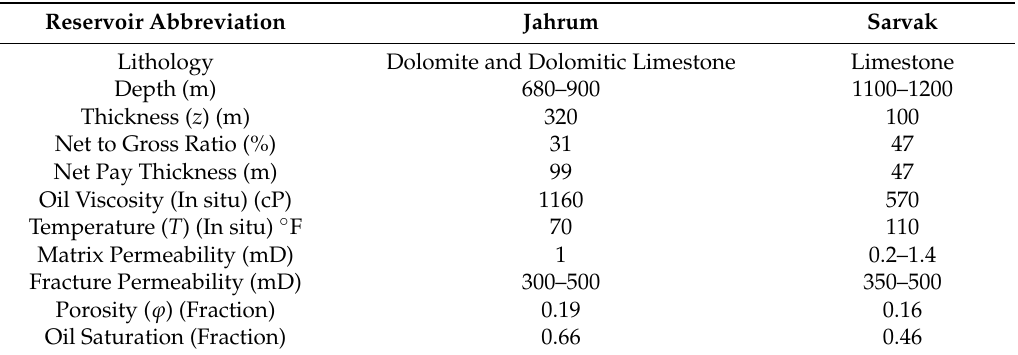
Table 9. Reservoir and fluid properties of reservoirs at the Kuh-e-Mond heavy oil